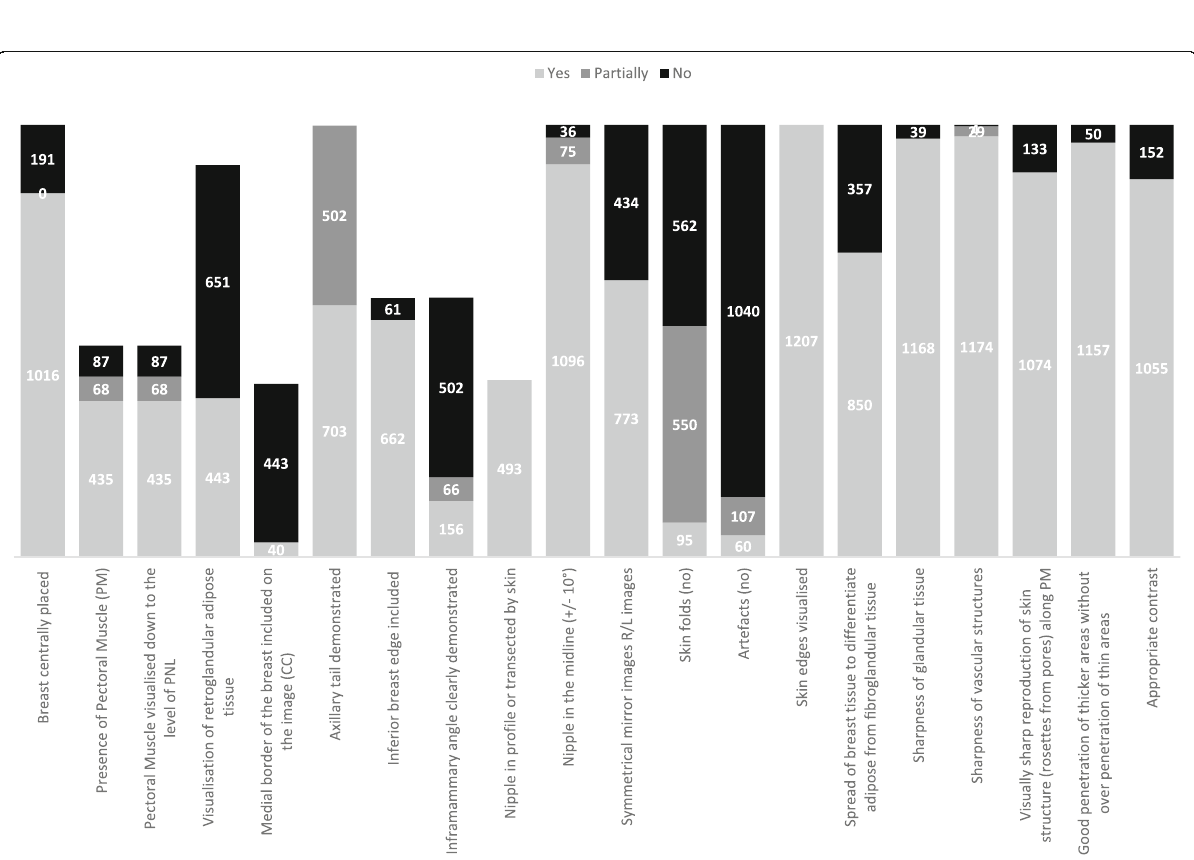
Fig. 3 Image quality criteria assessed (total): yes, criterion observed; partially, some images did not achieve the criterion; no, criterion not